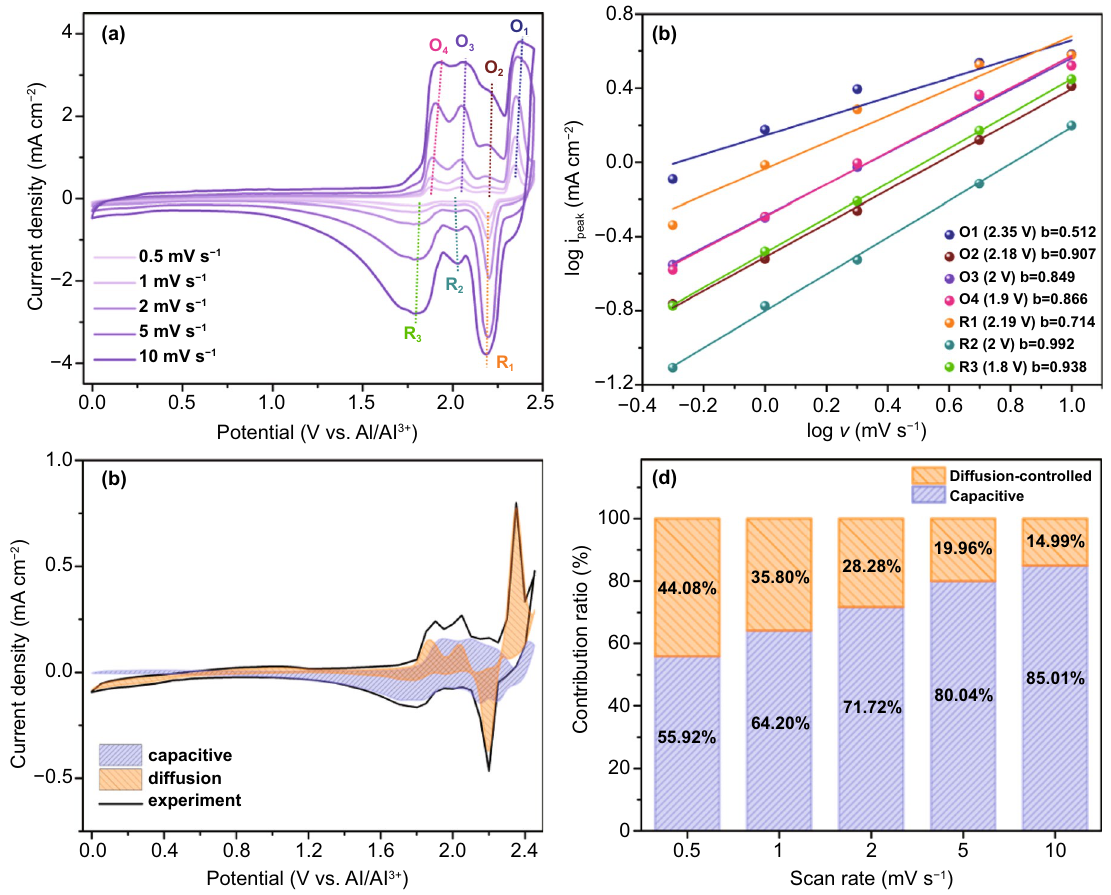
Fig. 7 a CV curves for the BEG cathode at different scan rates, b b -values at different redox voltages, c contribution ratio of the capacitive- and diffusion-controlled process at a scan rate of 0.5 mV s −1 , and d total capacity contribution ratio for the different scan